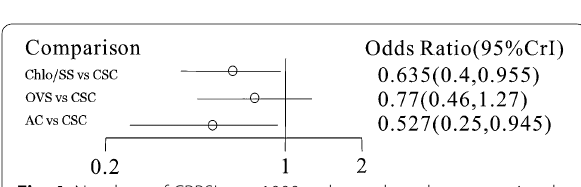
Fig. 4 Numbers of CRBSIs per 1000 catheter-days: the conventional standard catheter versus chlorhexidine/silver sulfadiazine and antibiotic